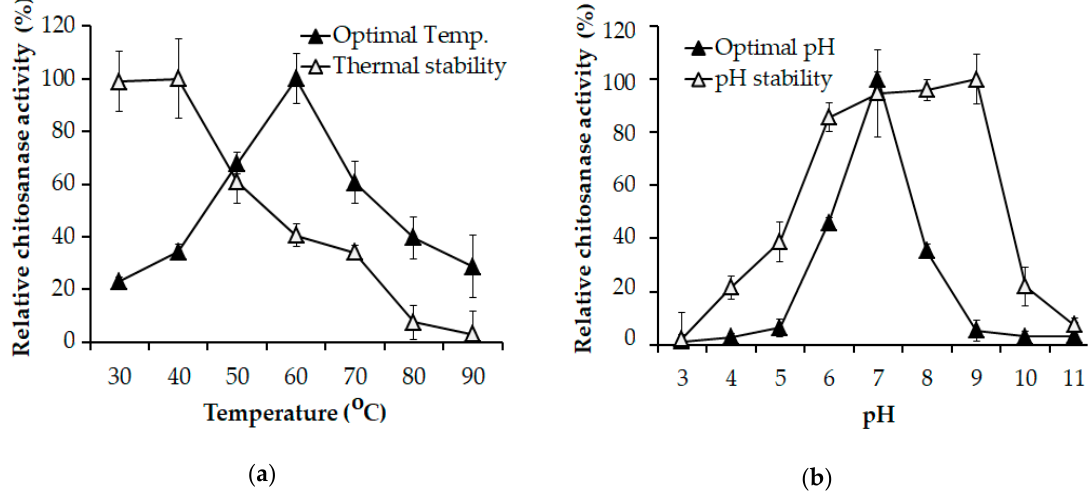
Figure 3. Effects of ( a ) temperature and ( b ) pH on the activity and stability of Paenibacillus sp. TKU047 chitosanase. All data points were the mean and standard deviation.